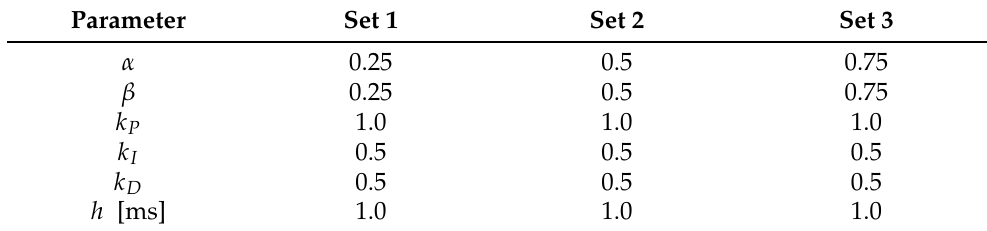
Table 3. Parameters of FOPID